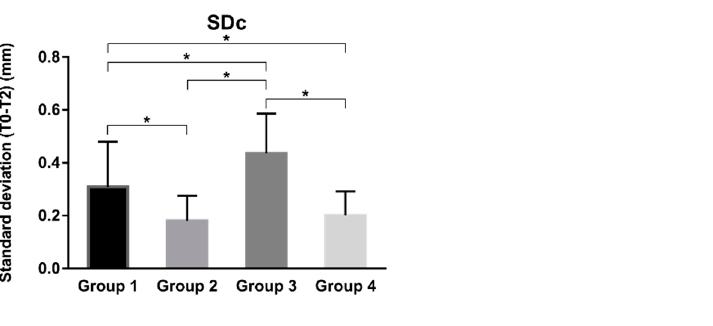
Figure 7. Results of the standard deviation of T0–T2 for different treatment modalities. Error lines represent +/ − standard deviation. * Statistically significant.